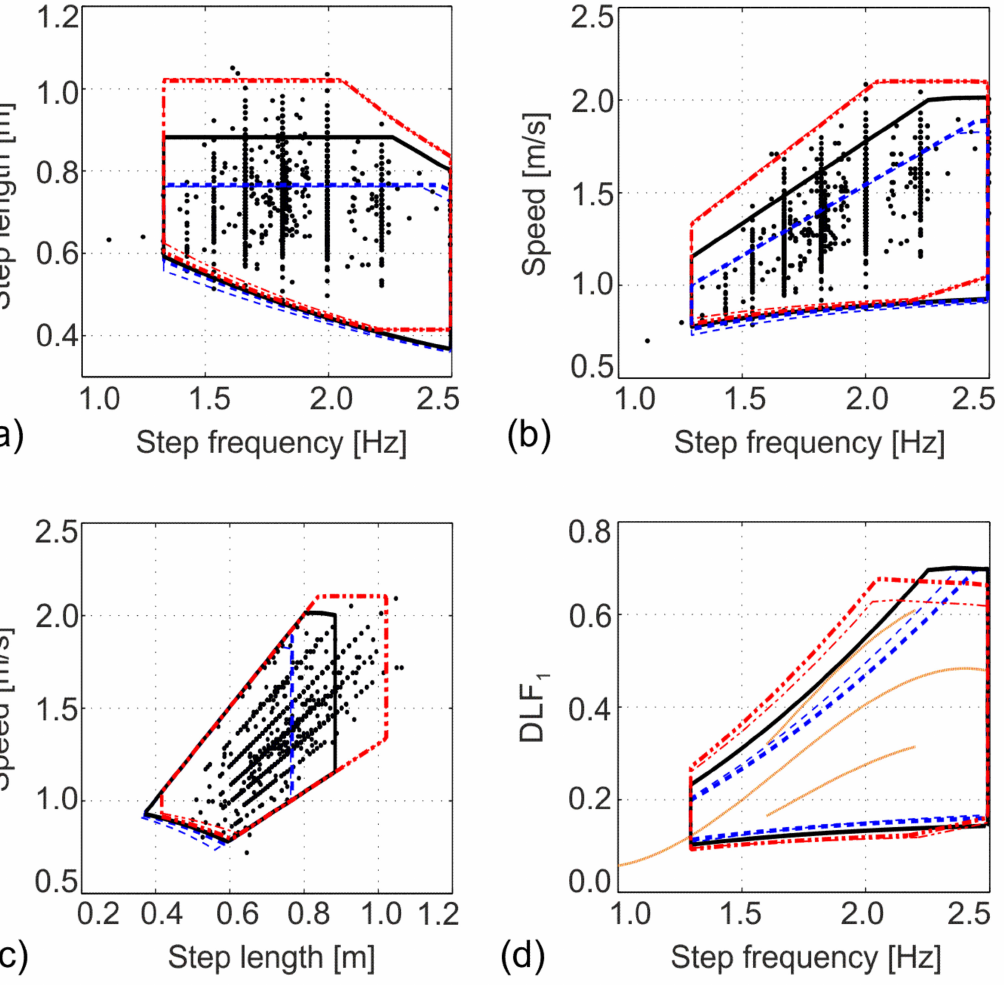
Figure 13. Relationships between ( a ) step length and step frequency, ( b ) speed and step frequency, ( c ) speed and step length, and ( d ) DLF1 and step frequency, in the IPRFM. Blue dashed lines: l + r = 0.9 m (thick l = 0.6 m and r = 0.3 m, thin l = 0.737 m and r = 0.163 m), black solid line: l + r = 1.037 m (thick l = 0.737 m and r = 0.3 m), red chain lines: l + r = 1.2 m (thick l = 0.9 m and r = 0.3 m, thin l = 0.737 m and r = 0.463 m). Black dots: experimental data from Figure 4, yellow thin solid lines in ( d ): experimental data (mean ± 2 STD) by Kerr